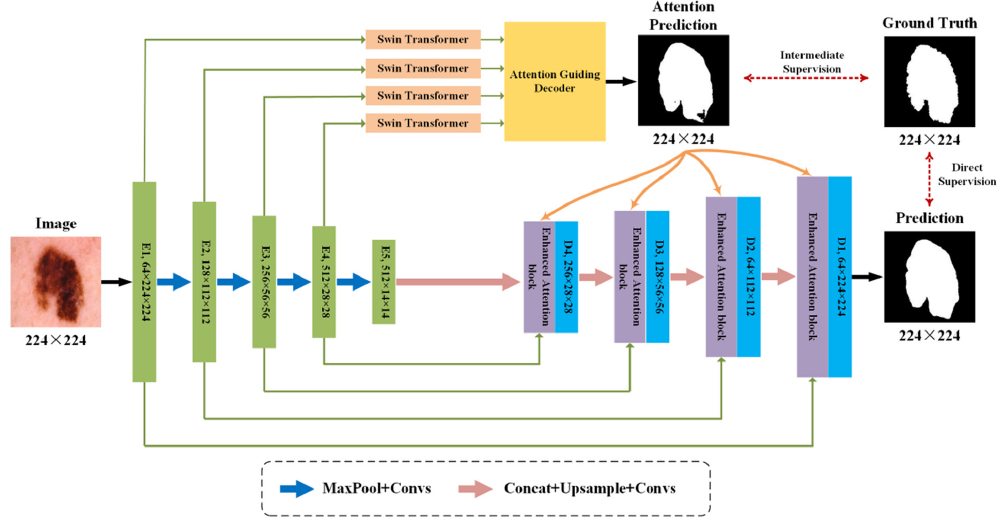
Figure 1. The illustration of the proposed Swin-PANet in the task of skin lesion segmentation. Swin- PANet follows the coarse-to-fine strategy and dual supervision strategy. It consists of two components: a prior attention network assisted by Swin Transformer performs intermediate supervision learning, and a hybrid Transformer network with enhanced attention blocks performs direct learning.